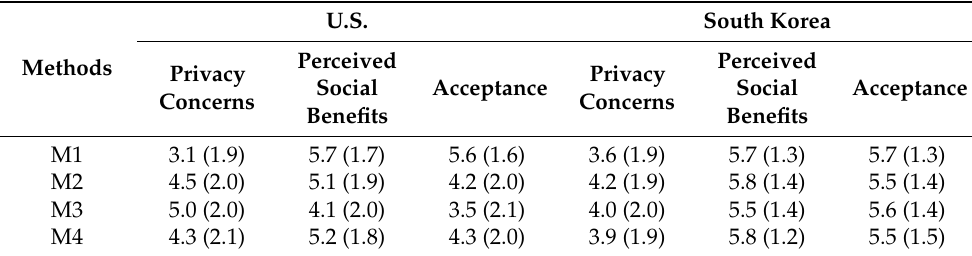
Table 3. Descriptive statistics of privacy concerns, perceptions of social benefits, and acceptance of the four contact tracing methods.